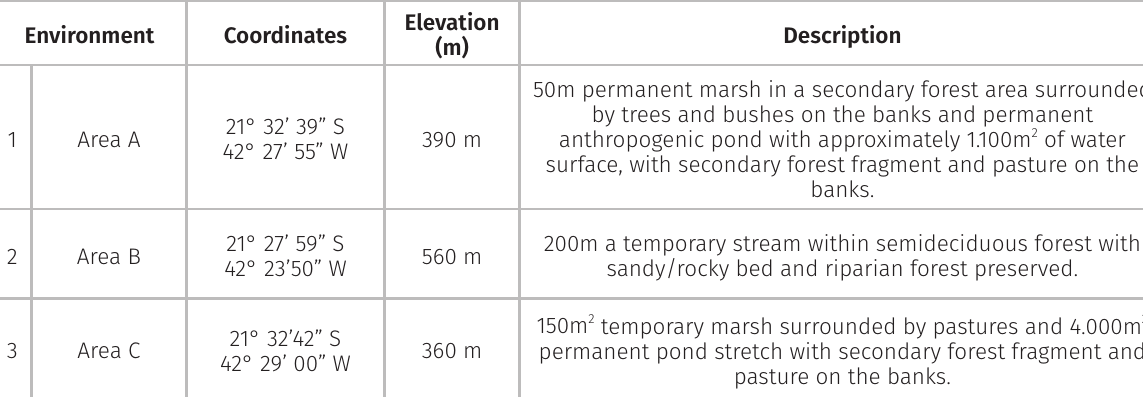
Table I. Environments monitored during rainy seasons 2013–2014 and 2014–2015 (October to March, respectively) in the Municipality of Barão de Monte Alto, State of Minas Gerais,